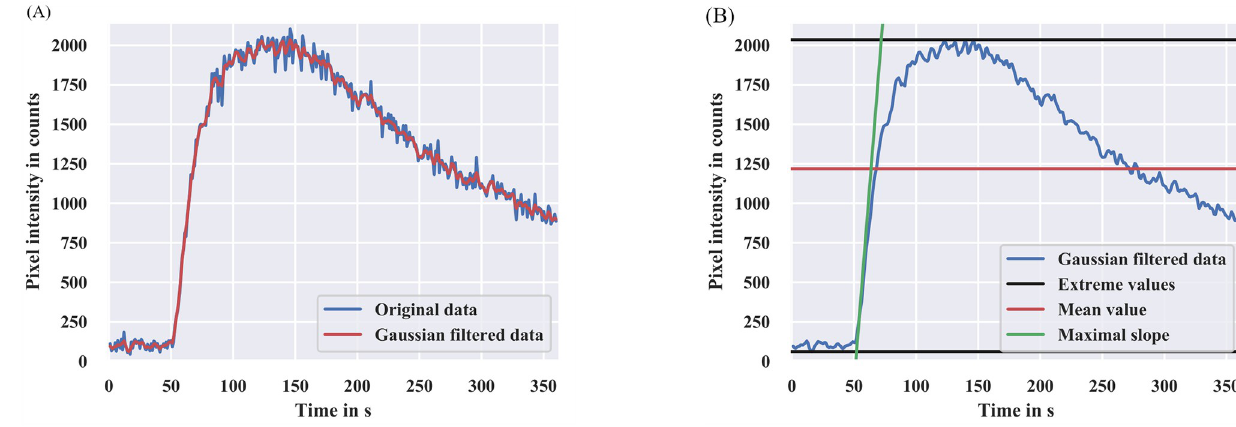
Fig 3. Smoothing and feature extraction of one representative pixel time series. (A) Gaussian filtering of the pixel time series. (B) Feature extraction of the pixel time series.